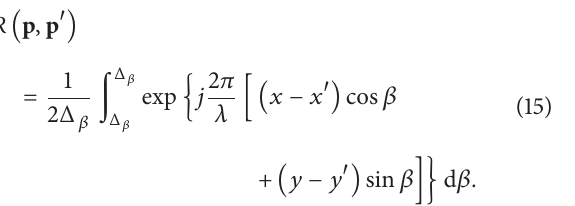
Figure 10: The optimal layout for Scenario IV with various 𝑑 max . a constraint that the antenna elements must be placed within a circle of diameter 𝑑 max :